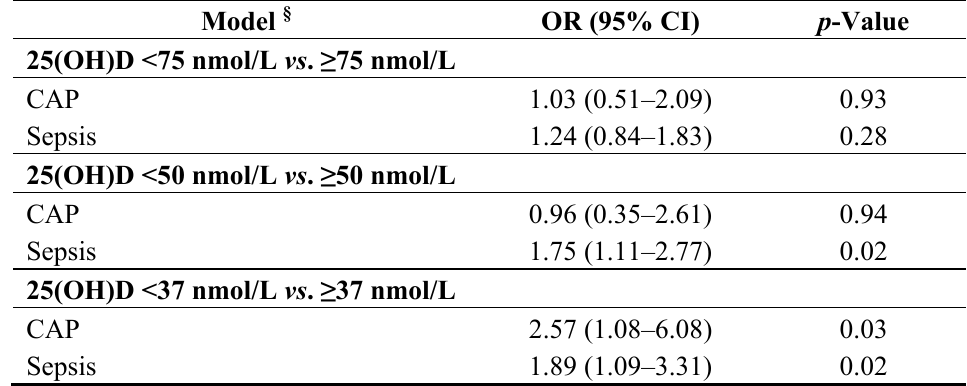
Table 2. Adjusted odds ratios for Community-Acquired Pneumonia (CAP) and Sepsis Cases relative to controls by serum 25(OH)D